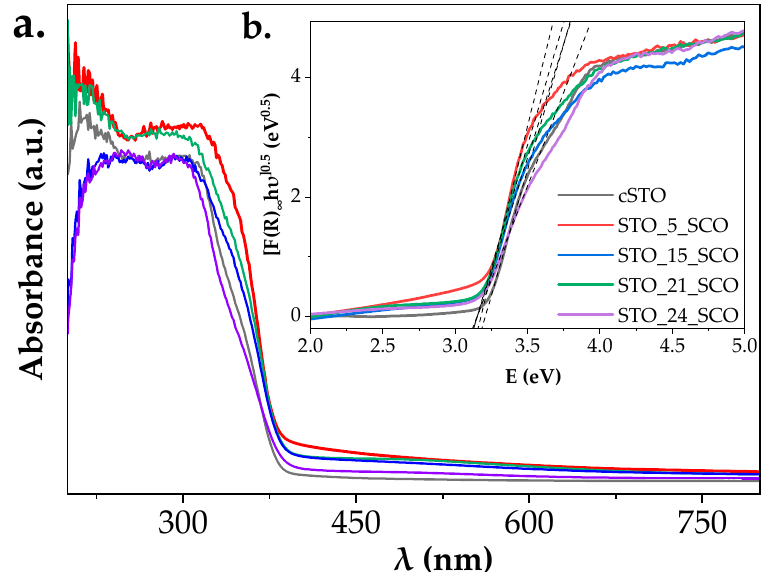
Figure 4. ( a ) UV-Vis spectra of SrTiO 3 -based catalysts; ( b ) Tauc-plot of the studied SrTiO 3 -based samples.